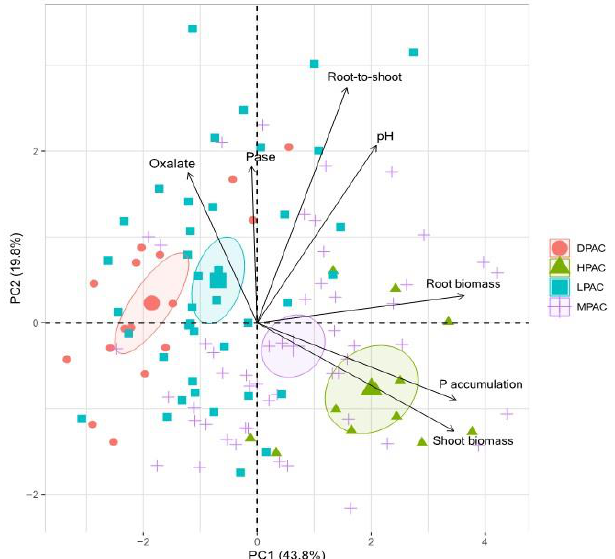
Figure 3. Principal component analysis of seven traits of 30 Chilean quinoa genotypes grown for 13 weeks in a volcanic soil with low available P. Biplot vectors are trait factor loadings, whereas the position of individual plants is shown. Abbreviations: high P acquisition capacity (HPAC), medium P acquisition capacity (MPAC), low P acquisition capacity (LPAC), and deficient P acquisition capacity (DPAC).